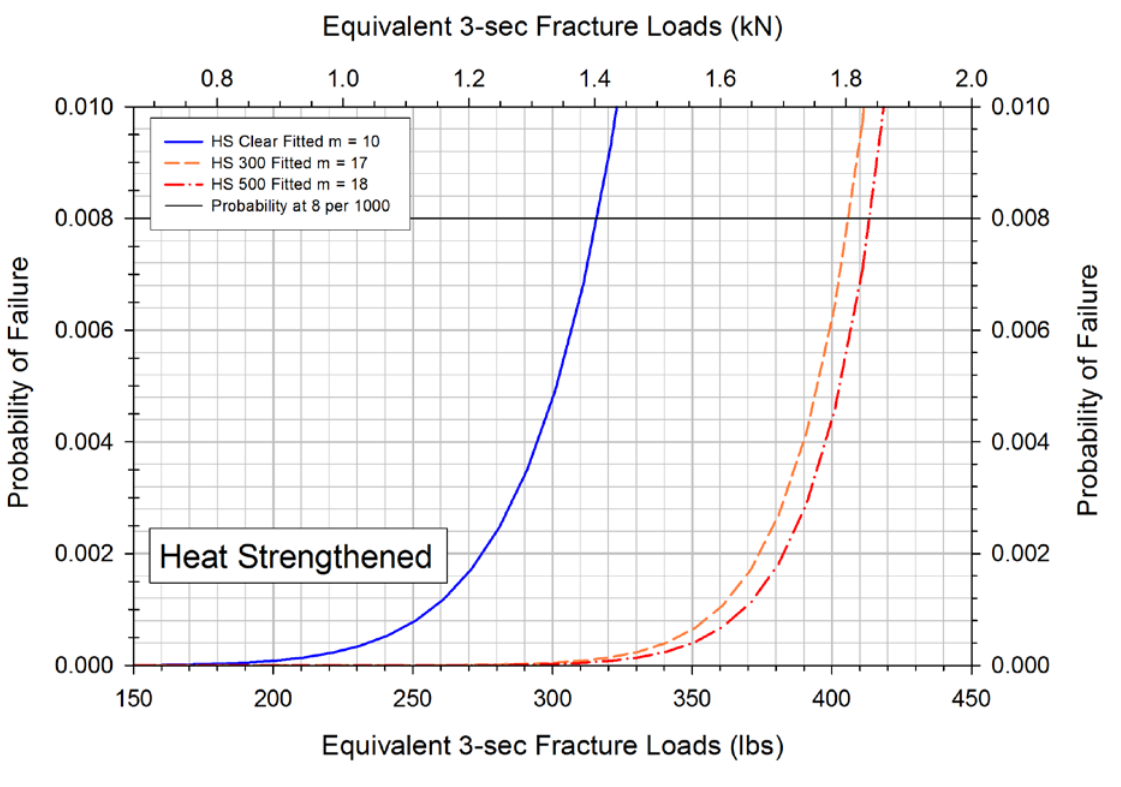
Figure 6. Fitted cumulative distribution function for the probabilities of failure less than or equal to 10 per 1000 for clear HS, OPACI-COAT-300®, and OPACI-COAT-500® specimens.